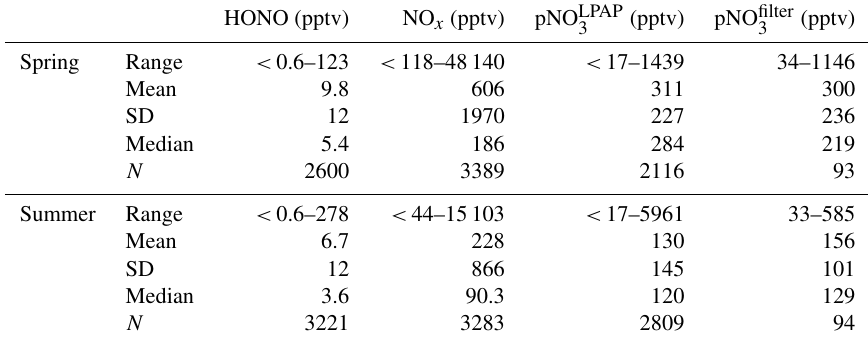
Table 1. Data statistics for the concentrations of HONO, NO x , pNO LPAP (16 August–10 September) of 2019 at the THMAO in Bermuda. For HONO, NO x , pNO LPAP performed based on 10min averaged